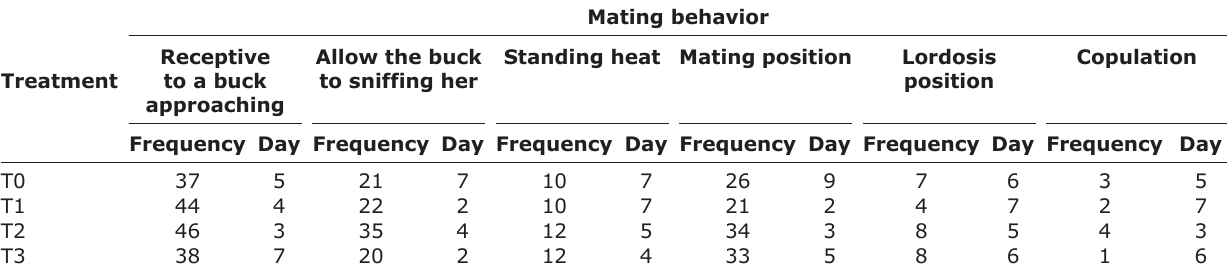
Mating behavior